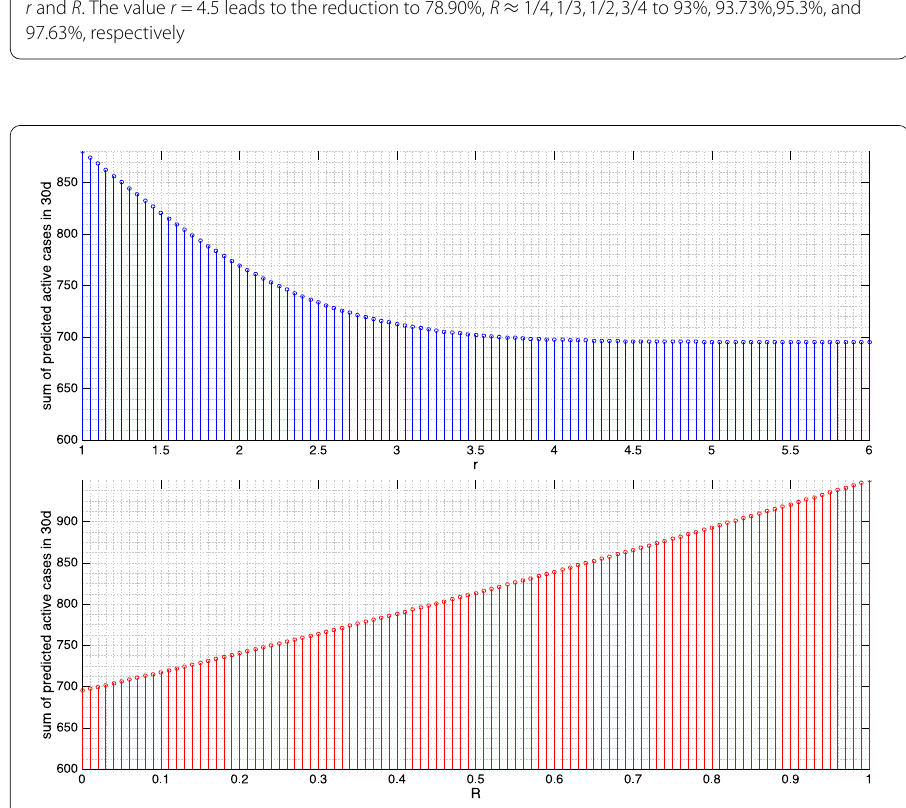
Figure 7 For the next 30d (April 12–May 11, 2020) in Sri Lanka, r = 4.5 leads to the reduction to 78.90%, R ≈ 1/4,1/3,1/2,3/4 to 79.19%, 81.2%, 85.64%, and 92.56%,